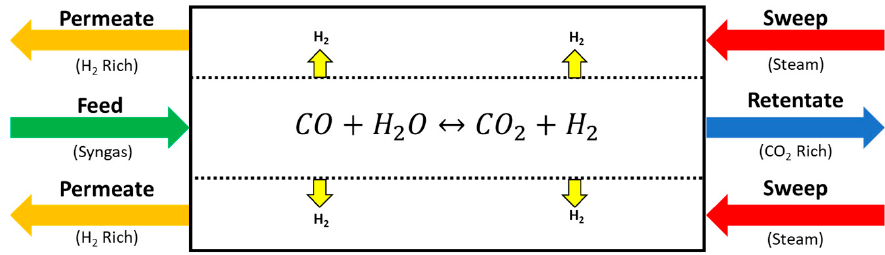
Figure 3. Schematic of the process operability concept. The fraction of the DOS covered by the green region would corre- spond to the operability index (OI) for the design.